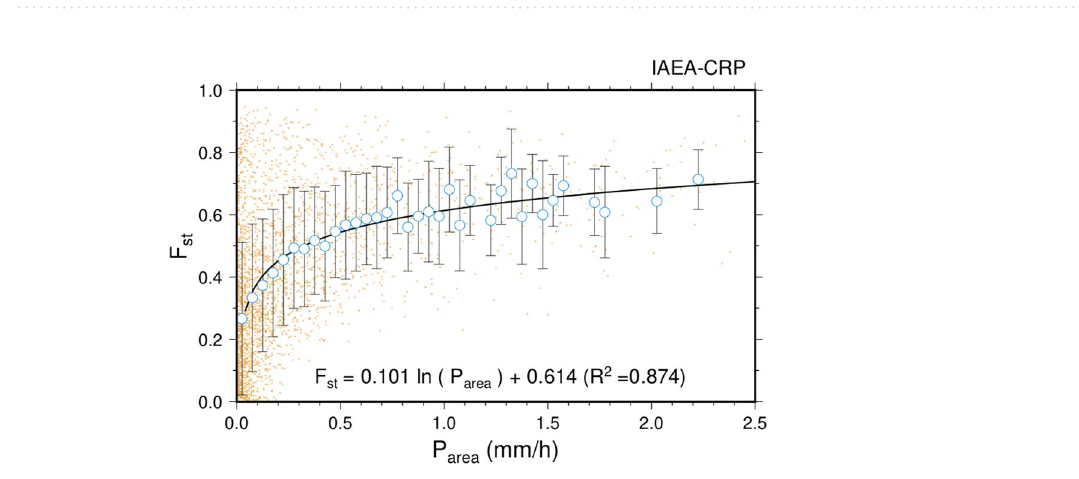
means that only a few GPM orbits pass through the domain (5° x 5° longitude/latitude box) within 10 days and so we cannot obtain daily convective/stratiform classification data from the satellite. As an alternative approach, we used area averaged (5° x 5° box) daily precipitation to estimate the daily F st . In the tropics, stratiform rainfall area is significantly larger than the convective rainfall area, and the increase in rain area is more likely to result in larger total rain amounts 33,34 . We found statistically significant relationships of area-averaged rainfall amount (P area ) to F st over the study domains at fourteen stations (i.e., Cairns, Darwin, 28 Millas, Heredia, Barisal, Cox´s Bazar, Port Blair, Nanyang Tech., Mulu, Ho Chi Minh City (HCM City), Kuala Terengganu., Kuching, Abetifi, and Amedzofe) from 2014 to 2017 (p < 0.05, R2 range = 0.25–0.72, mean R 2 = 0.53). As shown in Fig. 2, combining data from the 14 stations show a strong correlation between P area and F st (R 2 = 0.87, p < 0.01). However, at five inland or slightly extra-tropical stations (i.e., Rio Claro, Addis Ababa, Windhoek, Nagoya and SP Reyes) the relationships were weak, and we excluded these stations from further analysis. We then applied the correlation shown in Fig. 2 to a satellite-based daily precipitation dataset to estimate the daily F st over the study domain at 14 stations. A Tropical Rainfall Measuring Mission (TRMM) Multi-satellite Precipitation Analysis product, namely TMPA 3B42, was used to estimate area-averaged daily precipitation at each station. The TMPA 3B42 product has a 3-hourly temporal resolution and a 0.25° spatial resolution 35 . Original data are available online at http://disc. gsfc.nasa.gov/datacollection/TRMM_3B42_V7.shtml. Figure 3 shows the correlation between the 10-day moving average rainfall isotope data and stratiform rainfall area fractions > 0.01 for 14 tropical stations. Since there is a time lag for organized convective cloud systems (MCSs) in